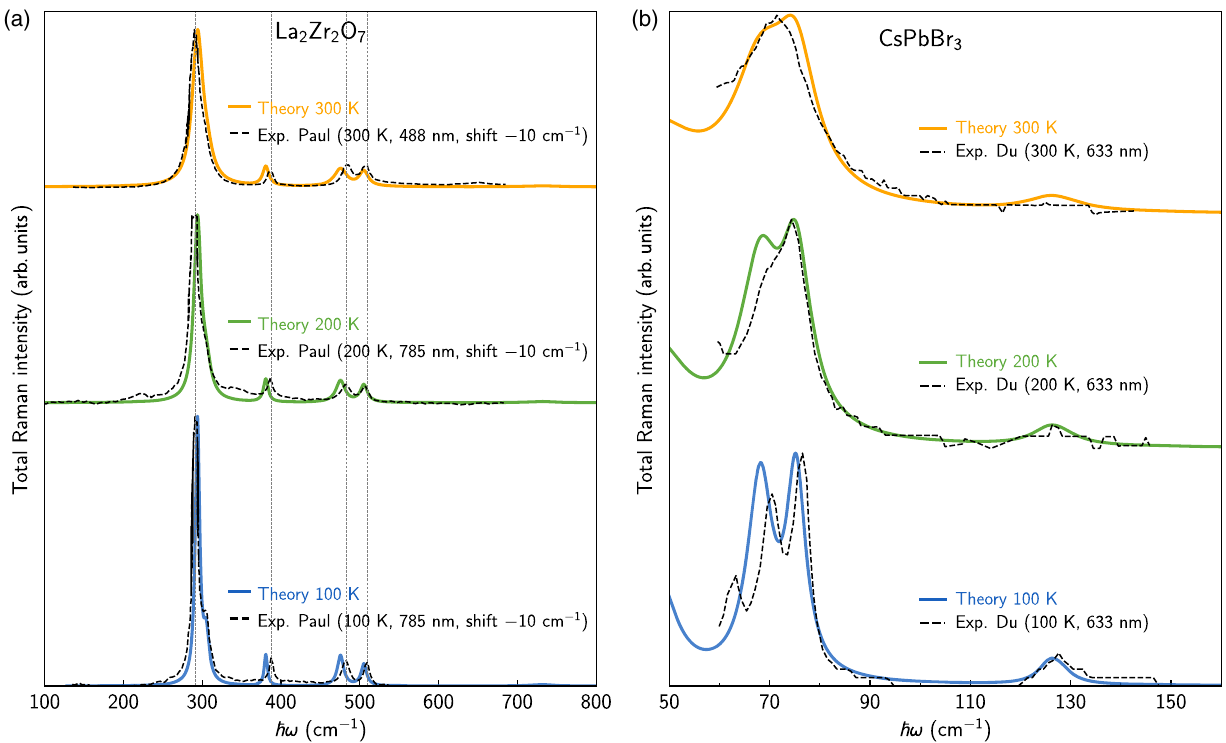
FIG. 11. Raman spectra of La 2 Zr 2 O 7 and CsPbBr 3 . Solid lines are temperature-dependent simulations performed relying on the same perturbative treatment of anharmonicity that we employed in our thermal-conductivity calculations. Dashed black lines are experiments, taken from Paul et al. [187] for La 2 Zr 2 O 7 , and from Du et al. [188] for CsPbBr 3 . The experimental measurements on La 2 Zr 2 O 7 in (a) have been shifted rigidly by 10 cm − 1 toward the left at all temperatures, to ease the comparison with our calculations. The vertical lines in (a) highlight that in La 2 Zr 2 O 7 the experimental Raman peaks do not have an appreciable temperature-dependent shift; thus the aforementioned rigid shift is not compensating for the temperature-dependent renormalization of the vibrational frequencies not accounted for in our calculations (see text for details). Overall, the temperature-dependent broadening of the experimental Raman peaks is in remarkably good agreement with our calculations; thus the perturbative treatment of anharmonicity employed is accurate enough for our illustrative